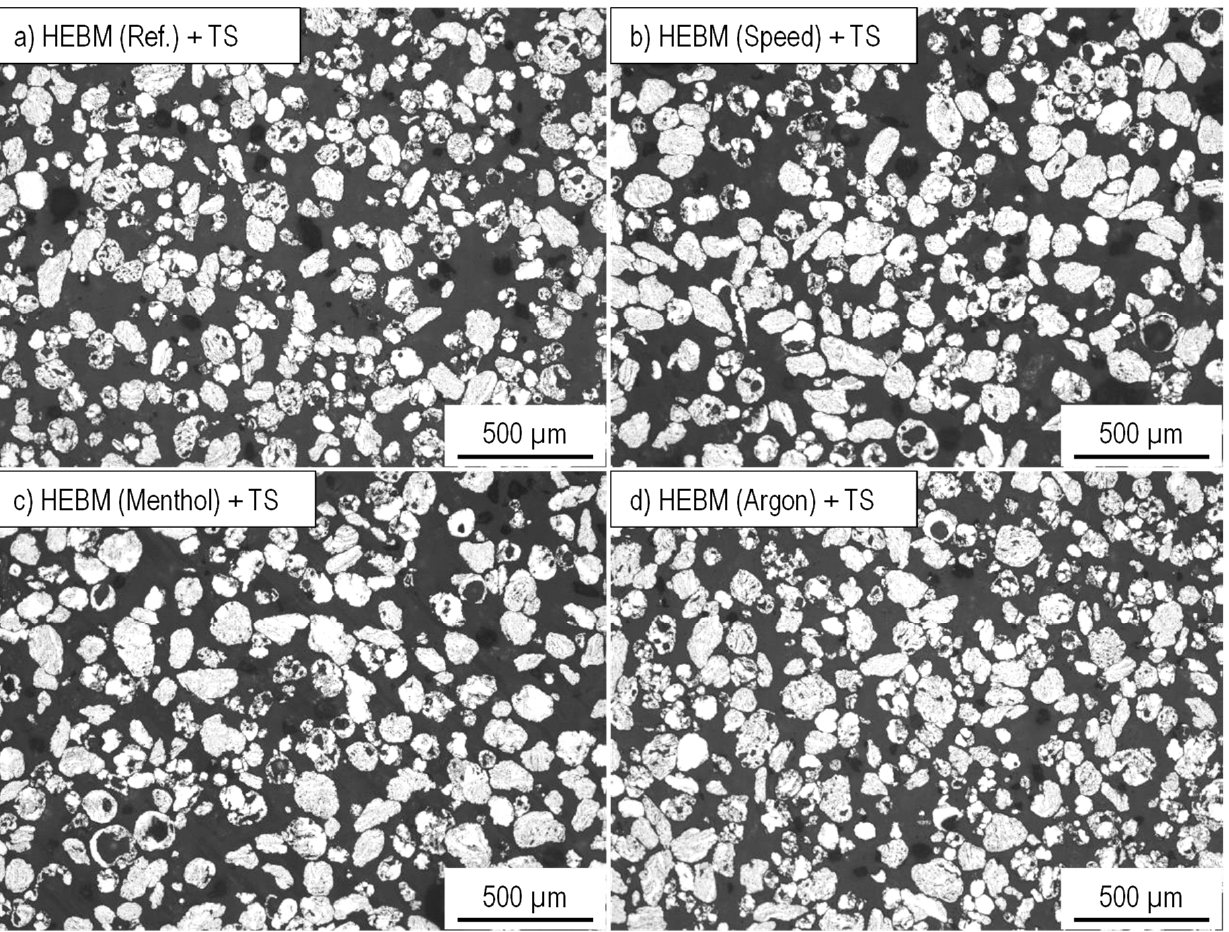
Figure 13. Thermal post-treatment by means of thermal spraying of HEBM-powder produced by ( a ) Reference Program, ( b ) Program1, ( c ) Program2 and ( d ) Program3.